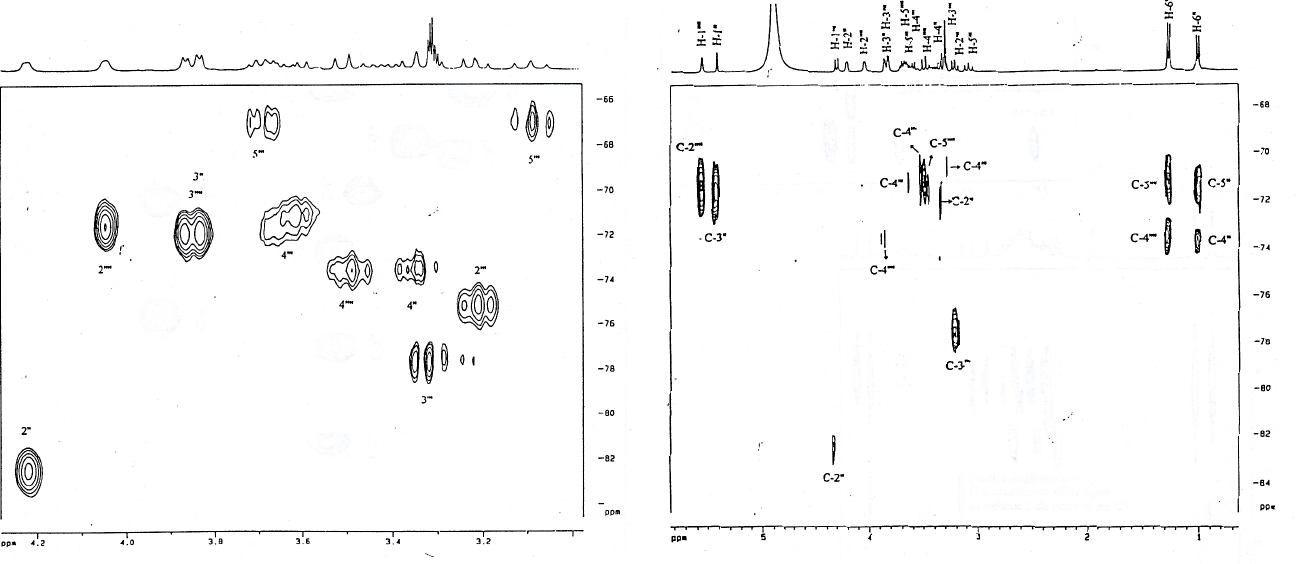
Figure S6 . HMQC spectrum of sagittatin A (300 MHz; CD 3 OD). Magnification of 3.0 – Figure S6: HMQC spectrum of sagittatin A (300 MHz; CD 3 OD). 4.3/65-83 ppm region. Magnification of 3.0 - 4.3/65 - 83 ppm region.